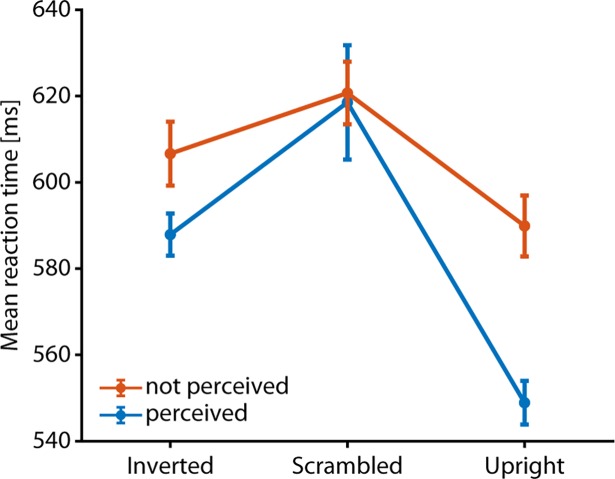
Reaction times.Subjects were faster when they perceived a face then when they did not, both in the upright and in the inverted condition (mean difference 29.8 ms, T(17) = 3.86, p = 0.001). They also showed a typical face inversion effect, taking longer to perceive inverted than upright Mooney faces (mean difference 38.9 ms, T(17) = 7.54, p<0.001). No reaction time differences between perceived and non-perceived scrambled images were observed (mean difference 2.1 ms, T(17) = 0.11, p = 0.906). Error bars reflect the standard error of the mean, corrected for between-subject variability [34, 35].